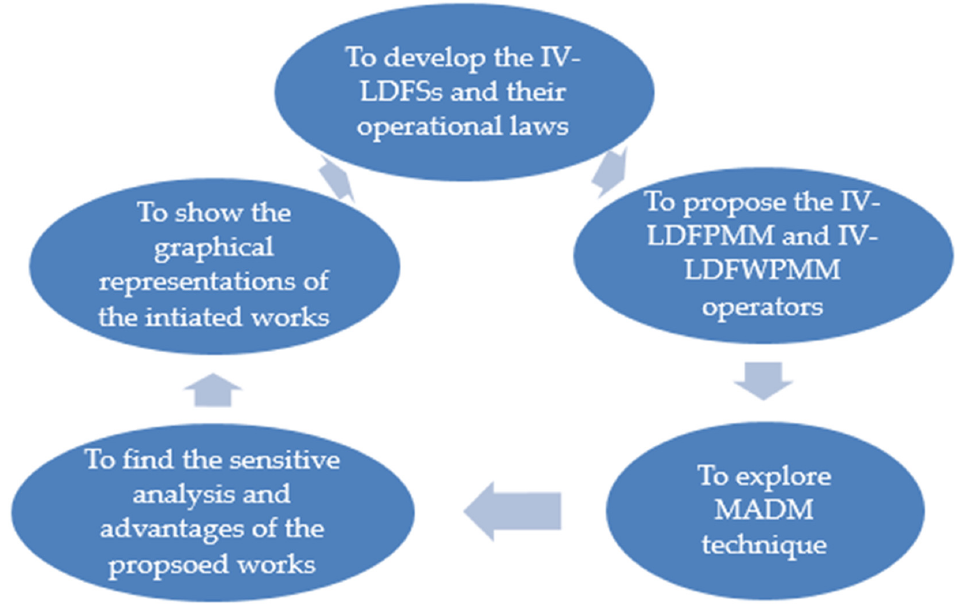
Figure 1. Graphical representation of the contributions.